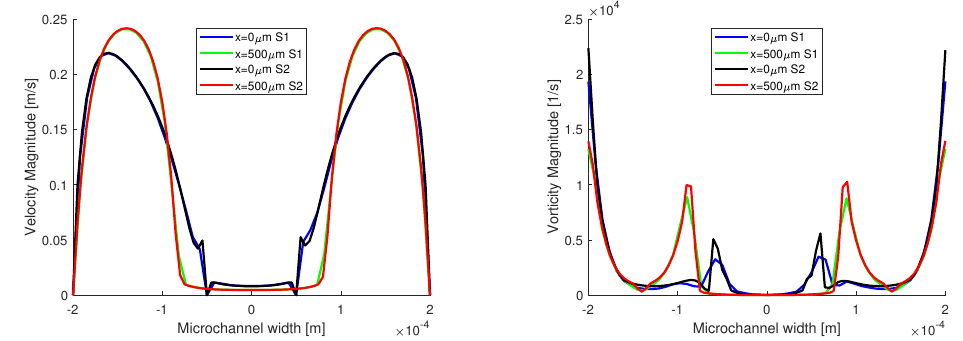
Figure 7. Velocity and vorticity distribution on two lines inside the